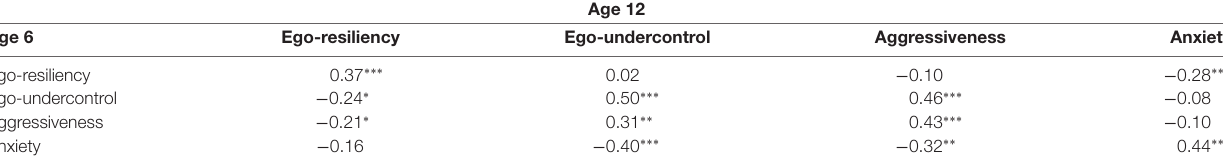
TABLE 3 | Longitudinal correlations among CCQ-personality variables at ages six and